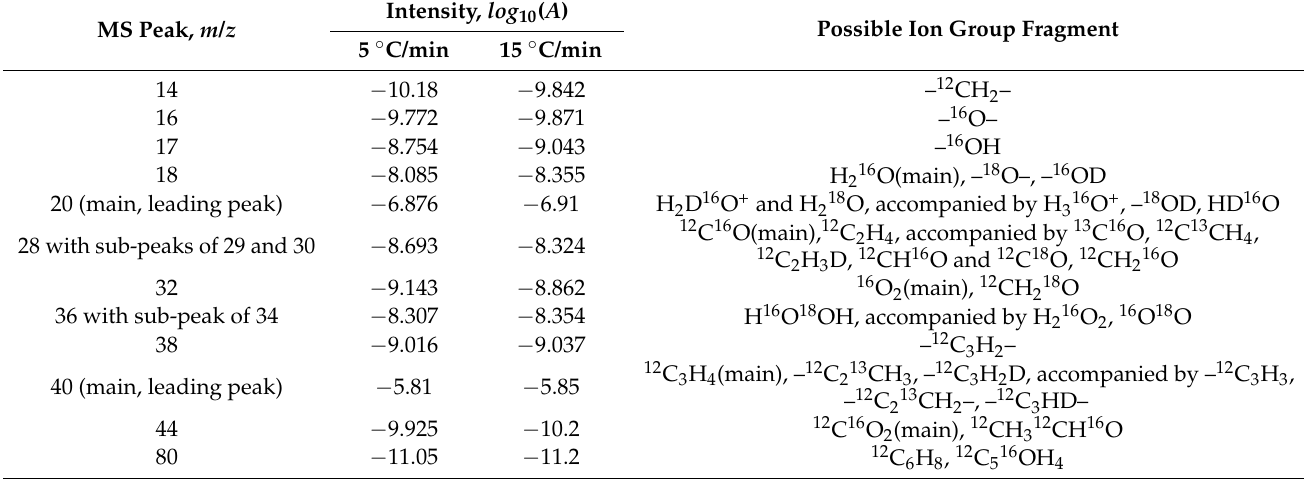
Table 2. MS peaks and possible ion group fragments from gas